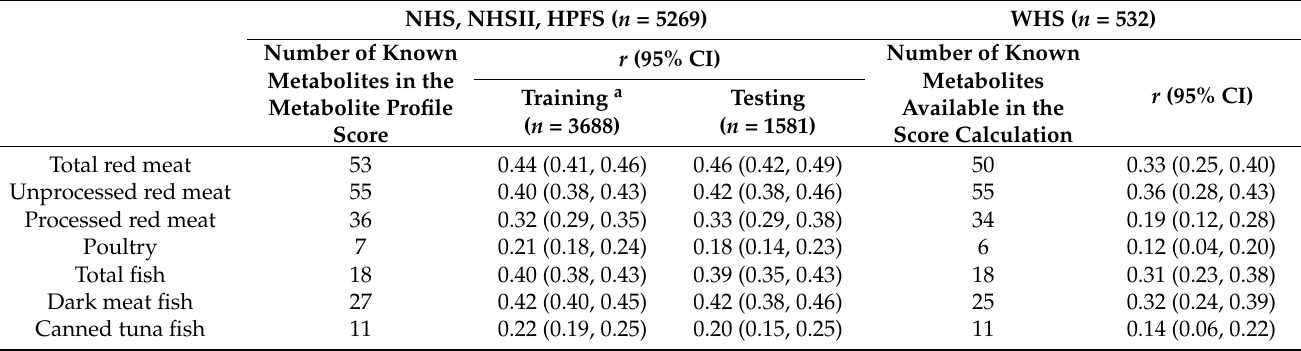
Table 2. Pearson correlation coefficients between meat and fish intake and the corresponding metabo- lite profile